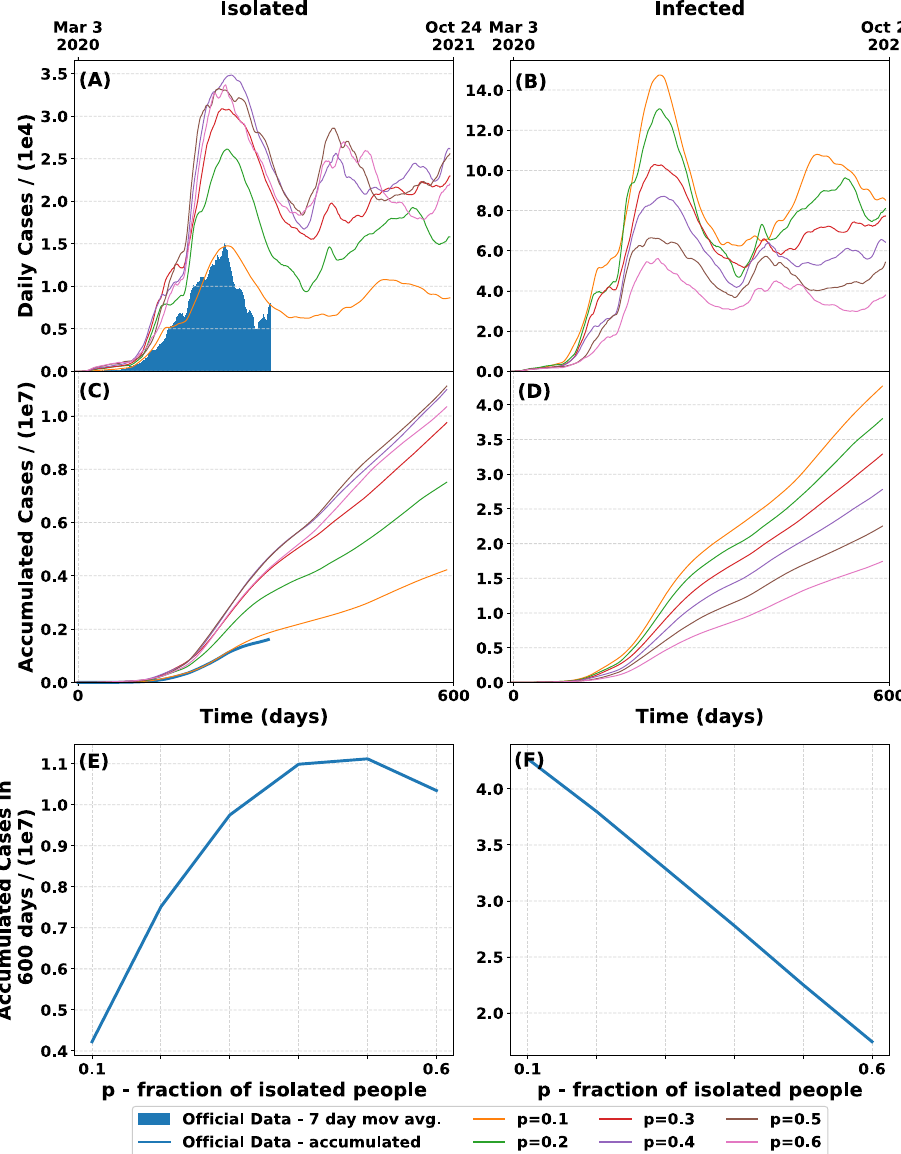
Figure 5. Prediction of geographical spread SEIQRS model according to different values of p . For each curve we did 100 runs of the model. The value α is fixed in 5 days and the mobility is the one fitted for p = 0.1 ( A ) Daily discovered (isolated) cases for different values of p compared with official data. ( B ) Daily actually infected cases. ( C ) Time evolution of accumulated isolated cases for different values of p . ( D ) Time evolution of accumulated infected cases for different values of p . ( E ) Accumulated isolated cases after 600 days as a function of the fraction of isolated infected people. ( F ) Accumulated infected cases after 600 days as function of the value p . In this case, the larger is the value of p the smaller is the amount of accumulated infected after 600